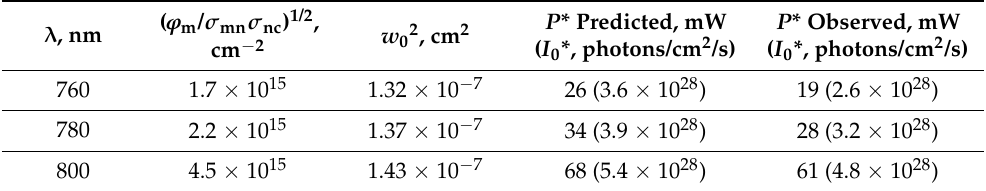
Table 2. Threshold laser powers P * and peak photon flux I 0 * for the transition from quadratic to super-quadratic dependence of the photobleaching rate for